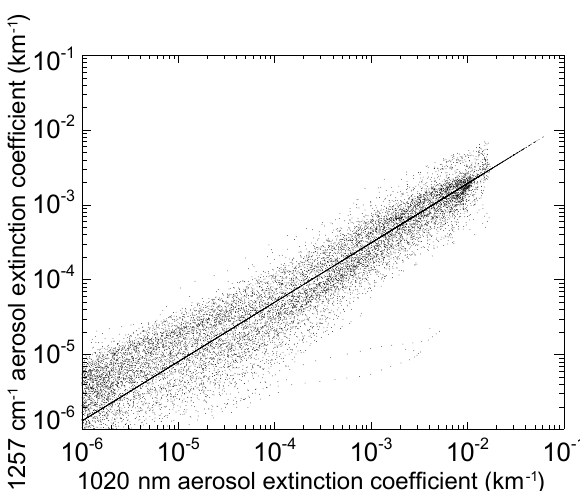
Figure 8. Observed relationship between gridded and cloud-cleared SAGE II observations (below 30km) as a function of SAGE II 1020nm observations. The blue line is the conversion relationship used for 1020–525 aerosol extinction conversion throughout GloS- SAC